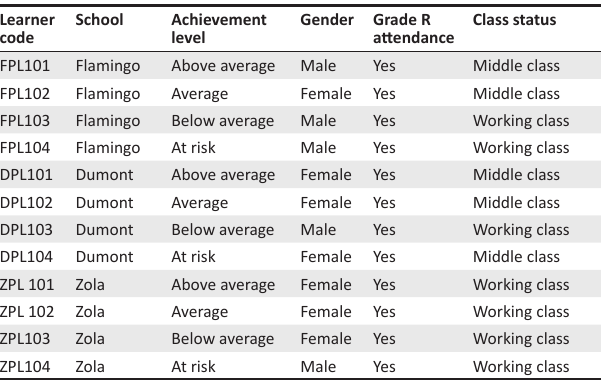
TABLE 2: The unit of analyses – The nature of the 12 learner participants across the three